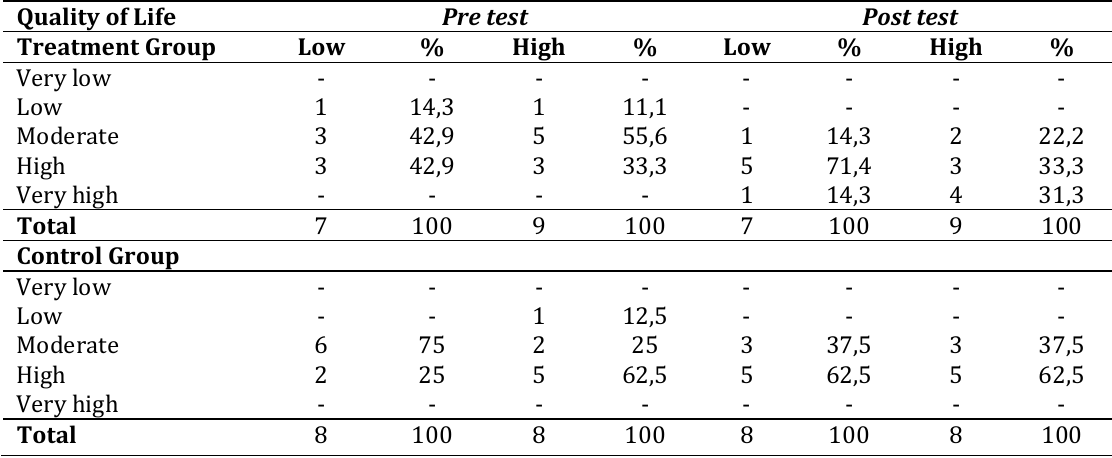
Table 7 Quality of Life in the Treatment and Control Groups Based on Income Quality of Life